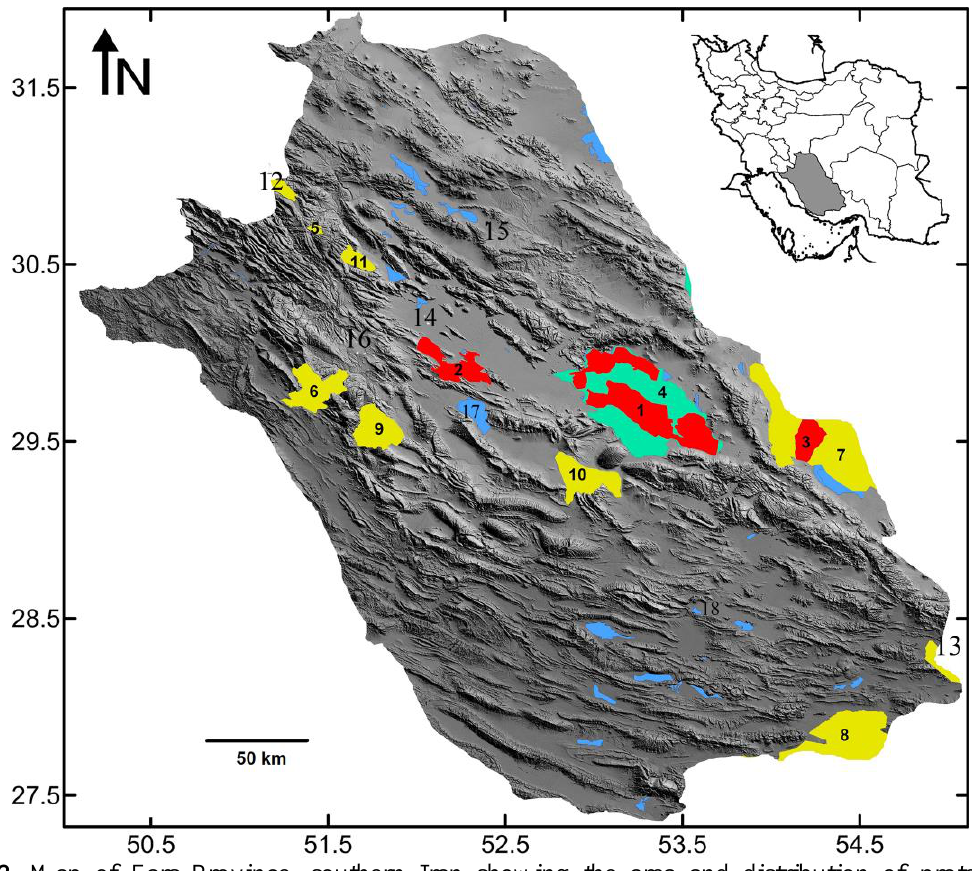
Figure 2. Map of Fars Province, southern Iran showing the area and distribution of protected and Important Bird Areas (IBAs). 1, Bakhtegan National Park; 2, Bamou National Park; 3, Qatruiyeh National Park; 4, Bakhtegan Wildlife Refuge; 5, Margoon Protected Area; 6, Arzhan and Parishan Protected Area; 7, Bahram-e Goor Protected Area; 8, Hermood Protected Area; 9, Moleh Galeh Protected Area; 10, Mianjangal Protected Area; 11, Tang-e Bostanak Protected Area; 12, Dena Protected Area; 13, Tarom Protected Area; 14, Dorudsan Dam; 15, Kaftar Lake; 16, Haft Barm; 17, Lake Maharlu; 18, Harm